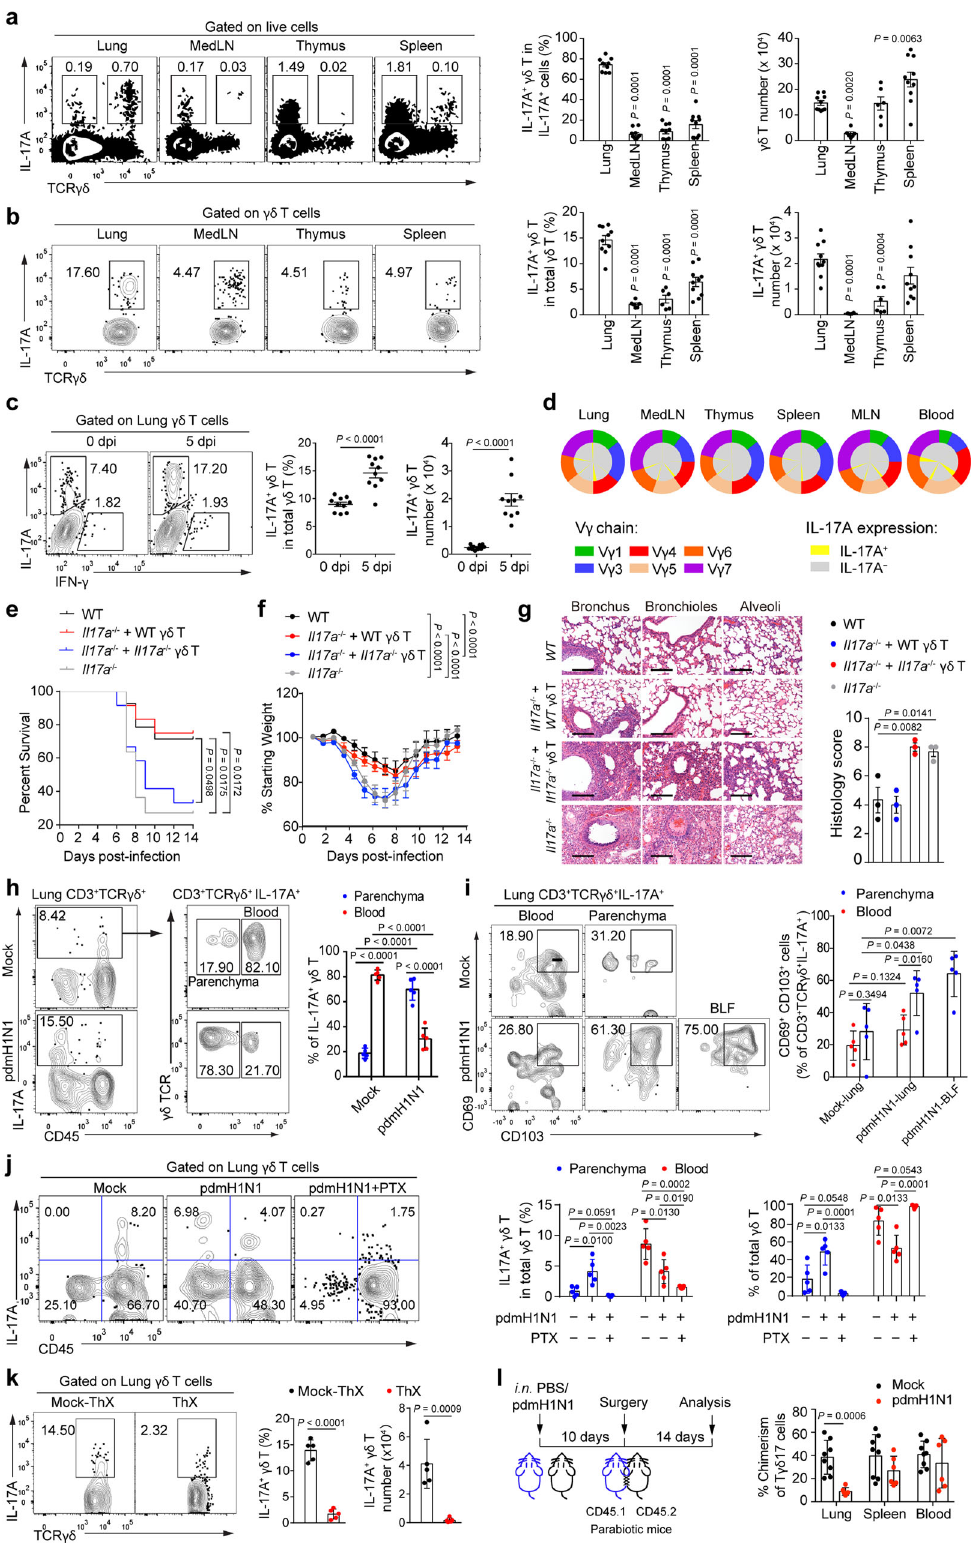
are highly prone to technical dropout, we then utilized a graph- based imputation method to clarify the potential relations between them. Consistent with our expectations, the imputed data revealed strong correlations in the expression pro fi les of the markers we identi fi ed with both Il17a and Rorc , while showing no relationship with the unrelated cluster marker Gzmb (Fig.